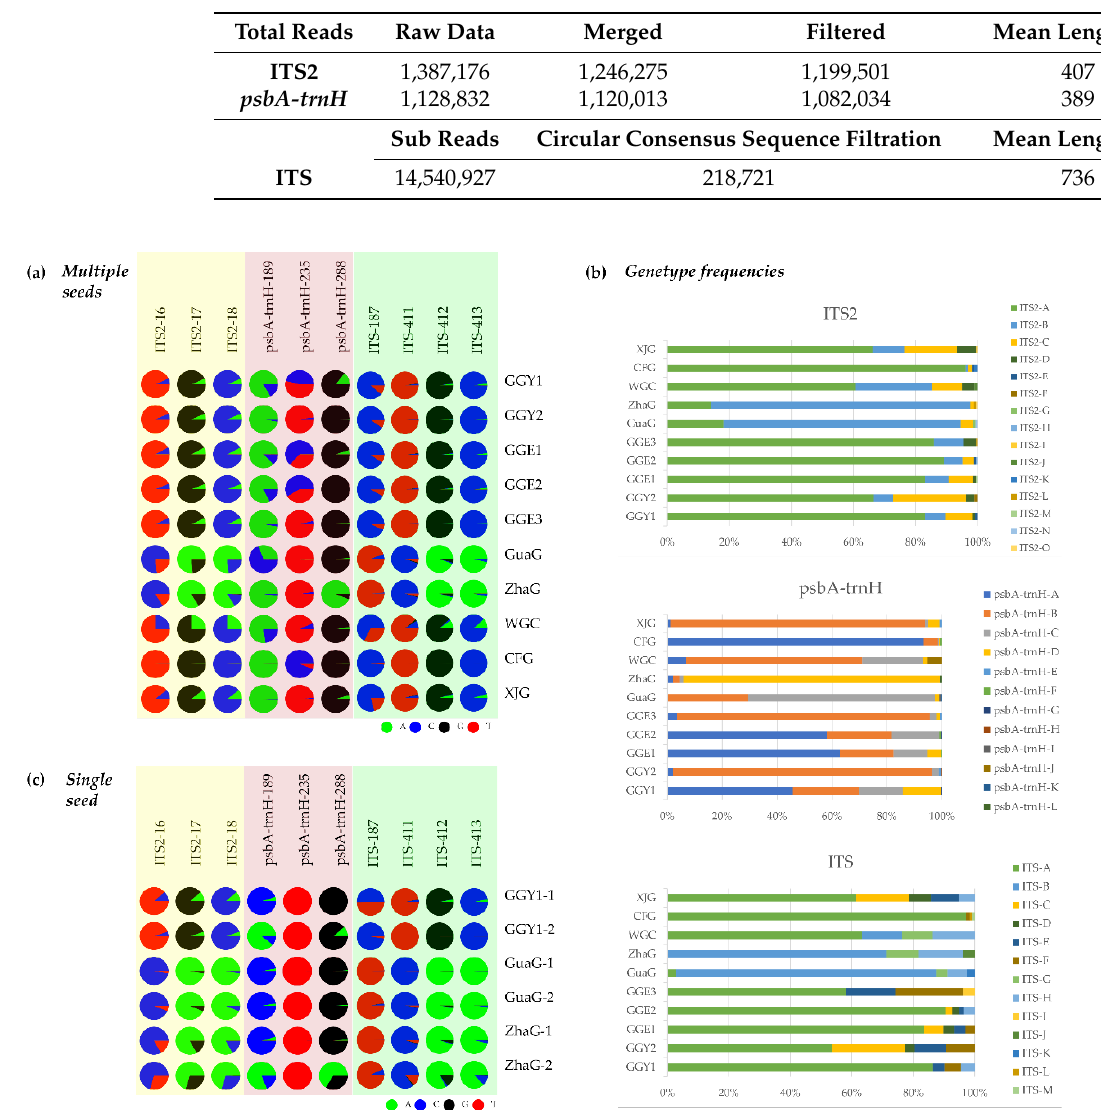
Table 2. Processing information for HFMD sequencing.